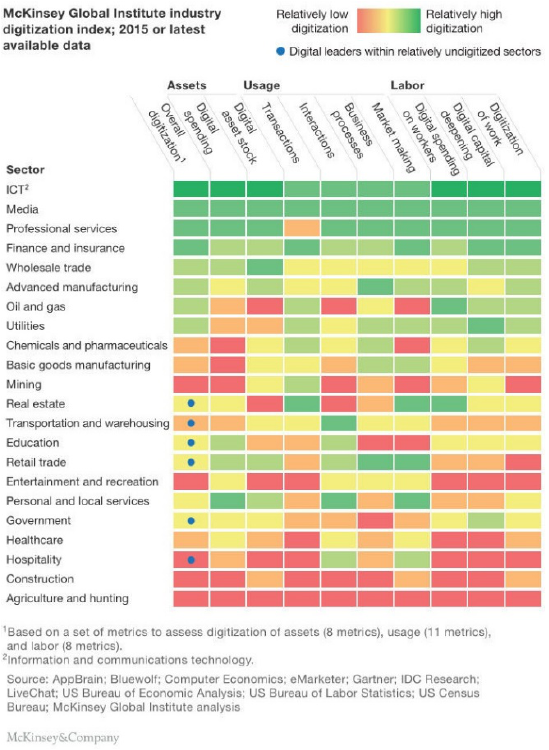
Fig. 1. Global industry digitisation index (McKinsey,